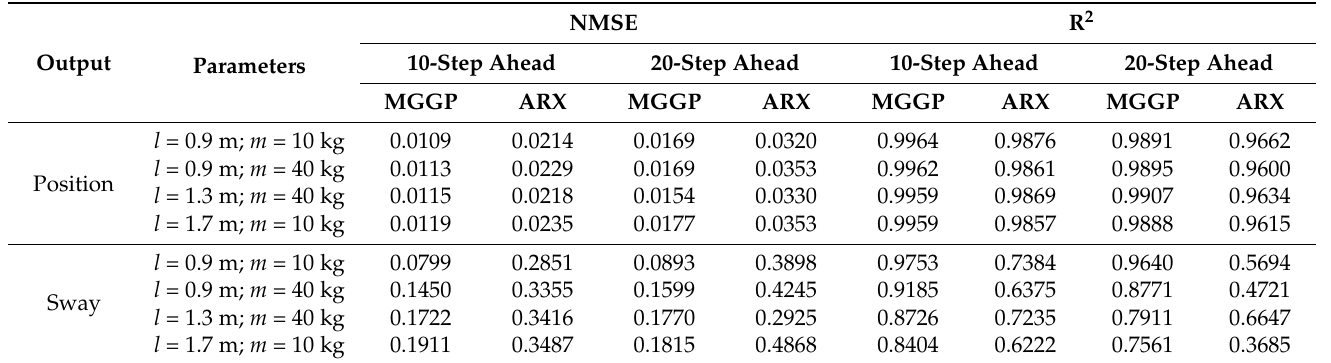
Figure 18. The 10- and 20-step ahead prediction with the ARX model of the experimental crane position and payload sway with 1.3-meter rope and 40 kg payload mass. Table 9. Statistics of the identified prediction model of experimental